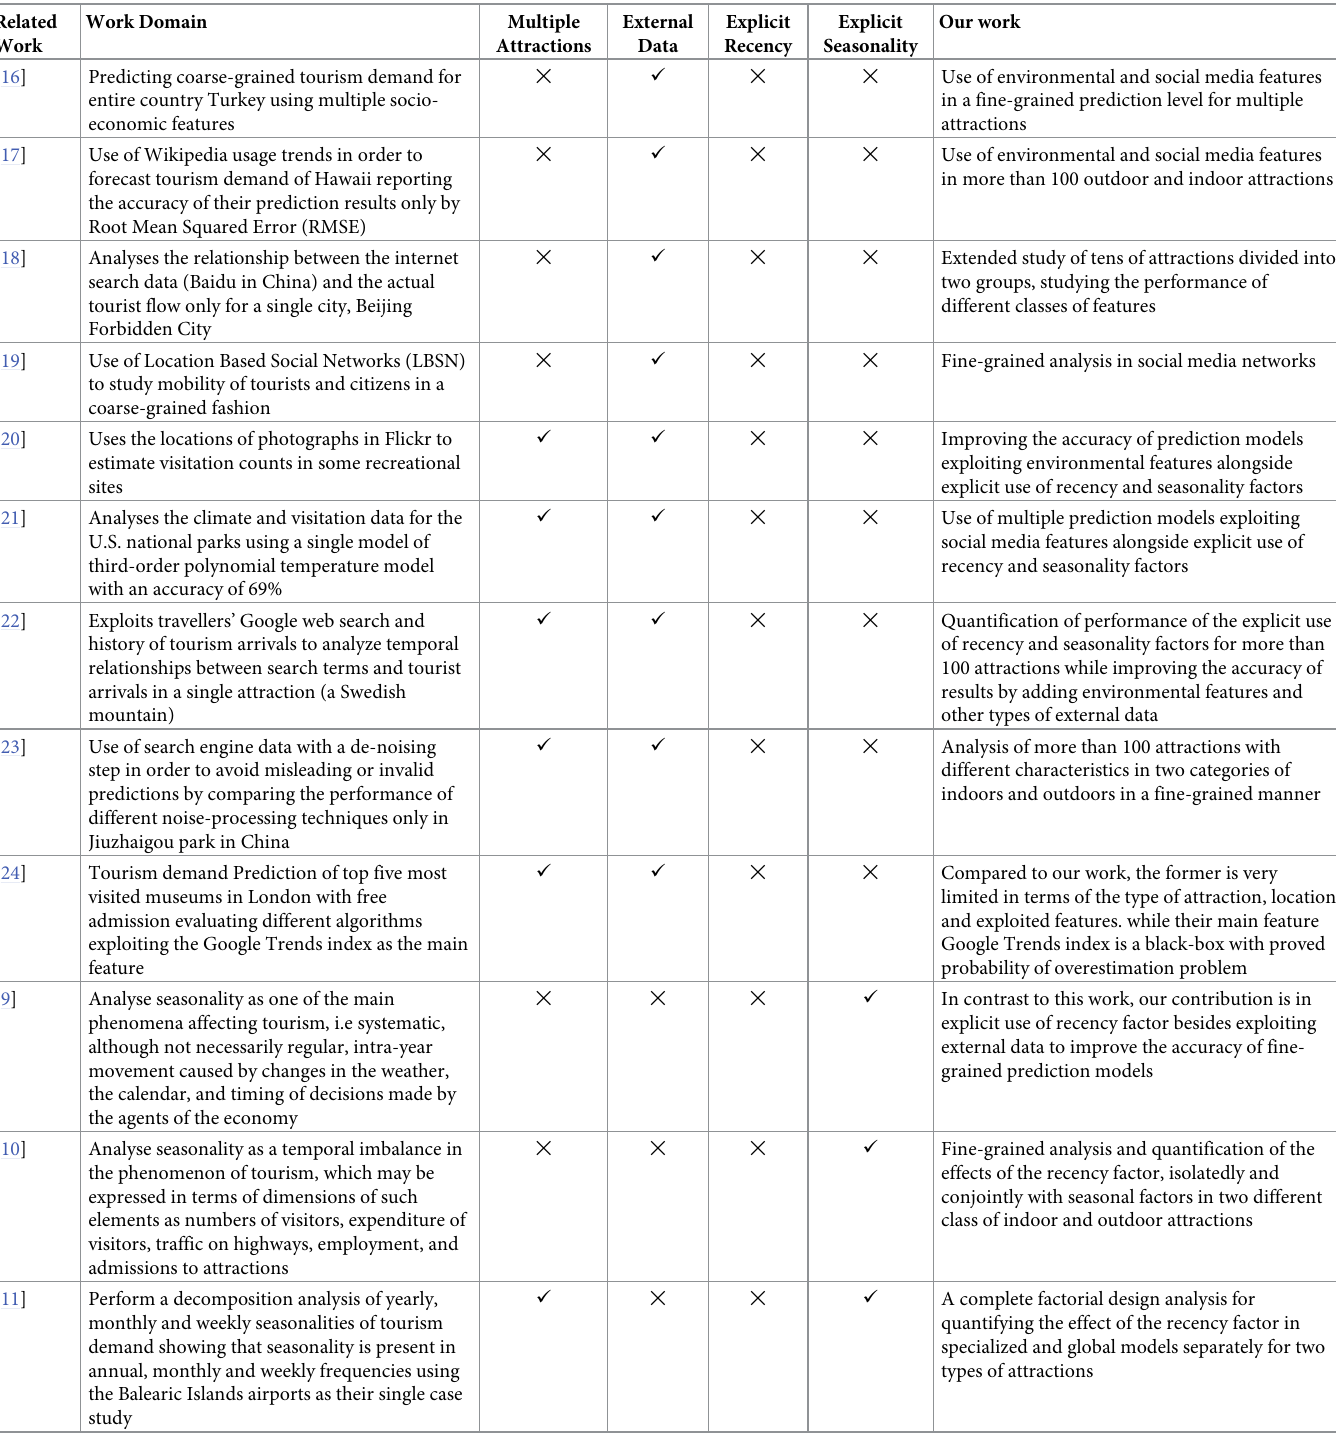
Table 1. Related work and our